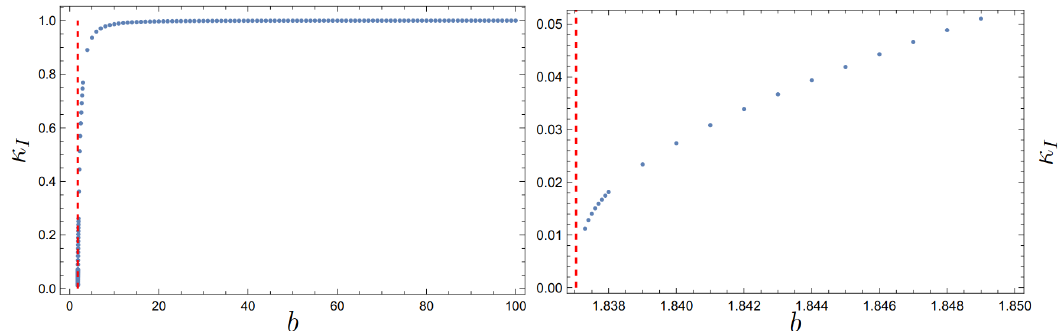
Figure 4 . The coefficient κ I , see (1.1), of the thermal order equation of state in the deformed Model I. The vertical dashed red line denotes b = b crit ,I